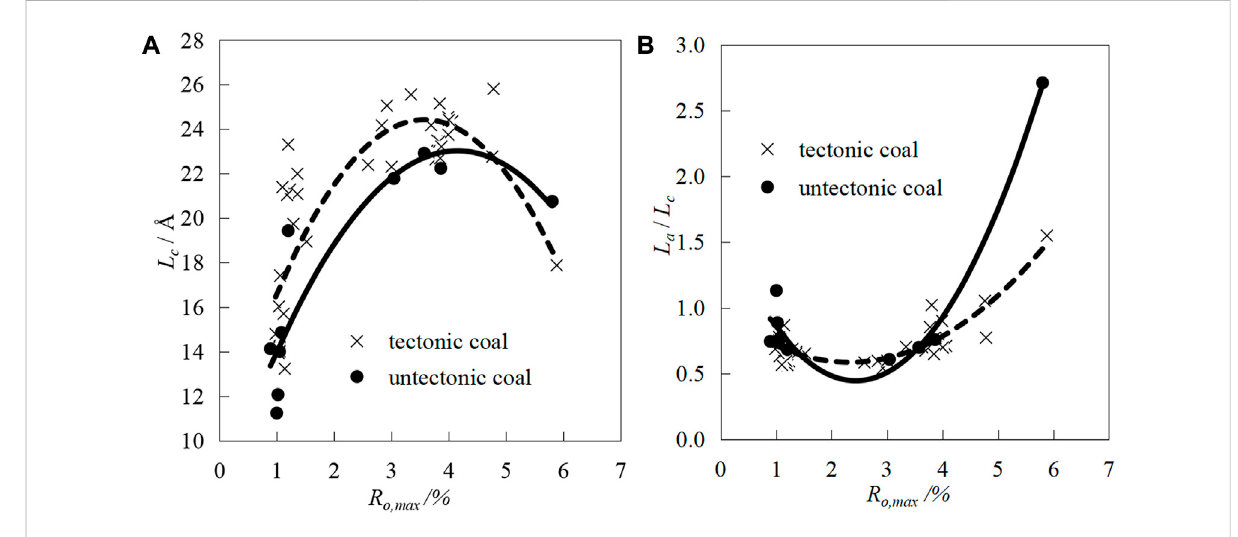
FIGURE 12 Growth characteristics of microcrystalline structure of tectonic coal and untectonic coal: (A) Relation between L c and R o ,max , (B) Relation between L a / L c and R o ,max (modi fi ed from Zhang et al.,